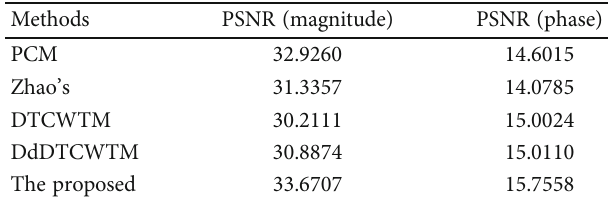
Figure 4: The fi rst row is the true magnitude image of the fi rst dataset and the magnitude results of the proposed method, PCM, Zhao ’ s method, DTCWTM, and DdDTCWTM, respectively. The corresponding magnitude error maps are shown in the middle row. The last line is the true phase image of the fi rst dataset and the phase results of these methods. Table 1: Comparison of PSNRs of the fi ve methods under the same sampling pattern for the fi rst dataset.